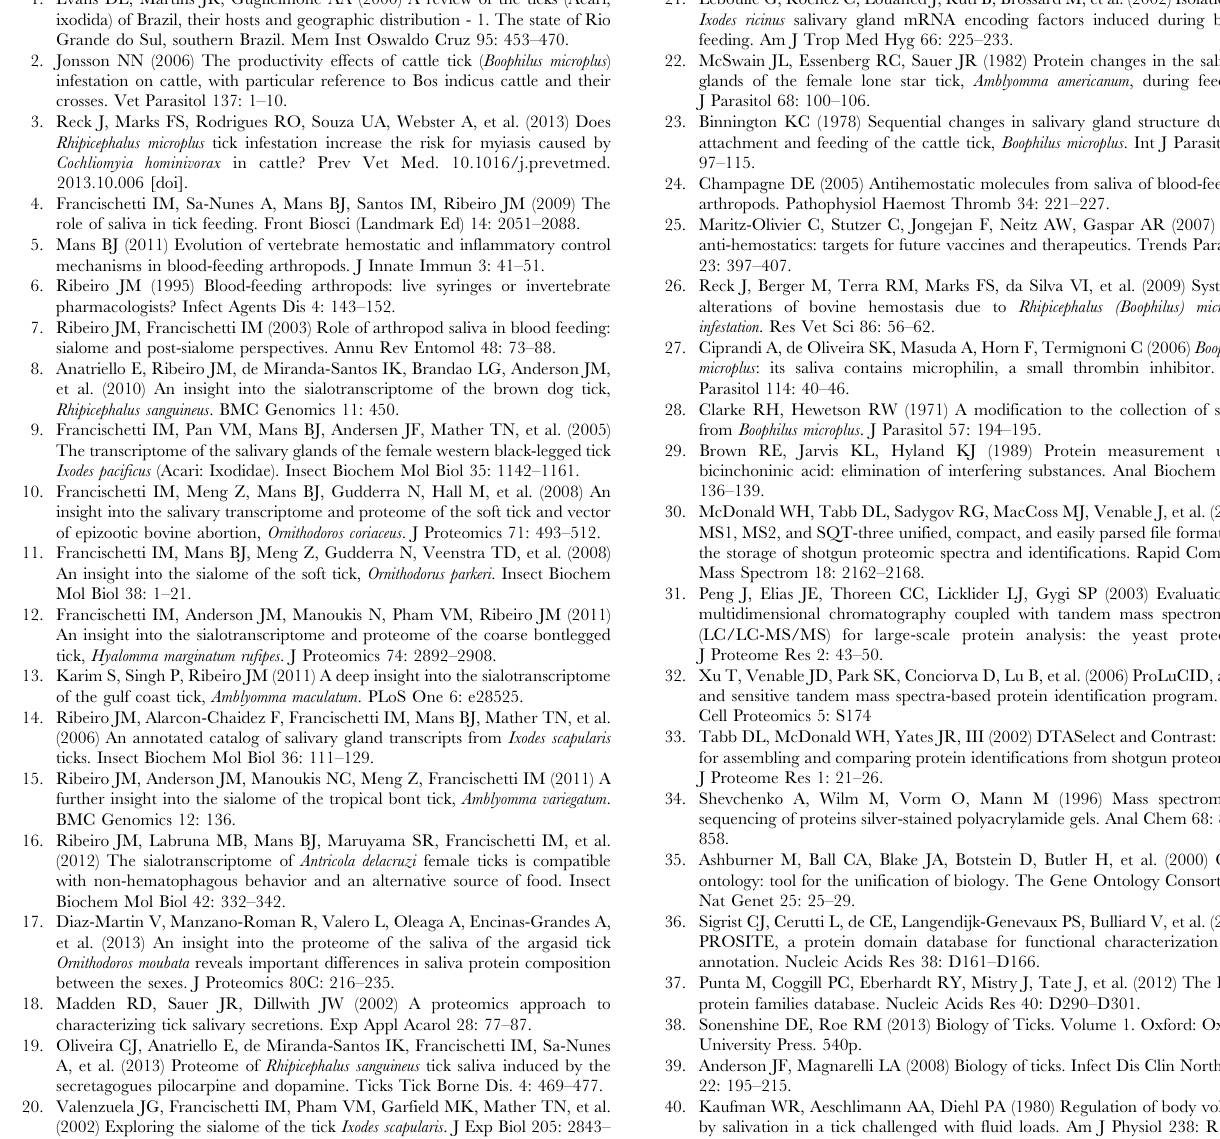
Table S2 Tick and host proteins identified in fully engorged female saliva by